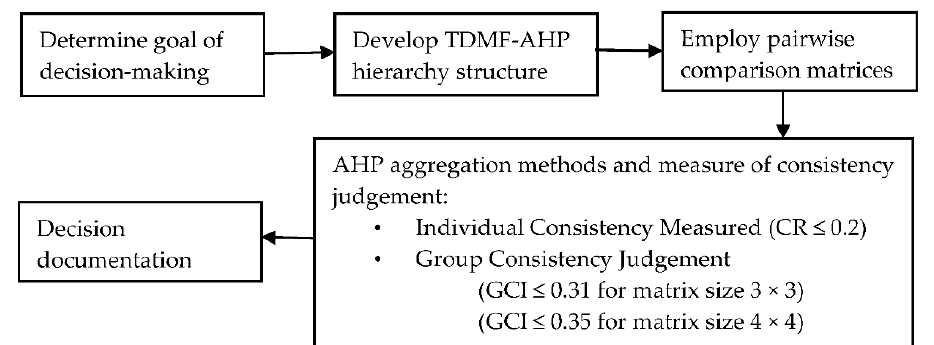
Figure 1. Methodology of the analytical hierarchy process (AHP) group decision-making process .